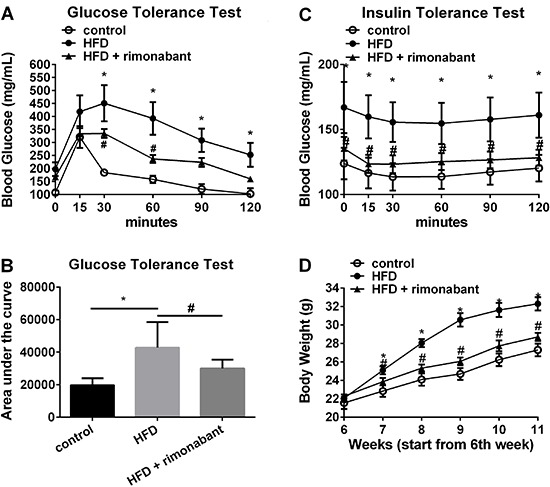

A, Glucose tolerance in mice fed a regular diet (control, n=6 mice), a high-fat diet (HFD, n=6 mice), or HFD+rimonabant (n=10) (A and B). C, Insulin tolerance test results for control (n=4 mice), HFD (n=4 mice) and HFD+rimonabant (n=4 mice) groups. D, Body weight of control (n=10 mice), HFD (n=10 mice) and HFD+rimonabant groups (n=14 mice) over a 5-week period. Results are reported as means±SE. *P<0.05 HFD vs control, #P<0.05 HFD vs HFD+rimonabant (A, C and D, two-way ANOVA with Tukey's multiple comparisons. B, one-way ANOVA).